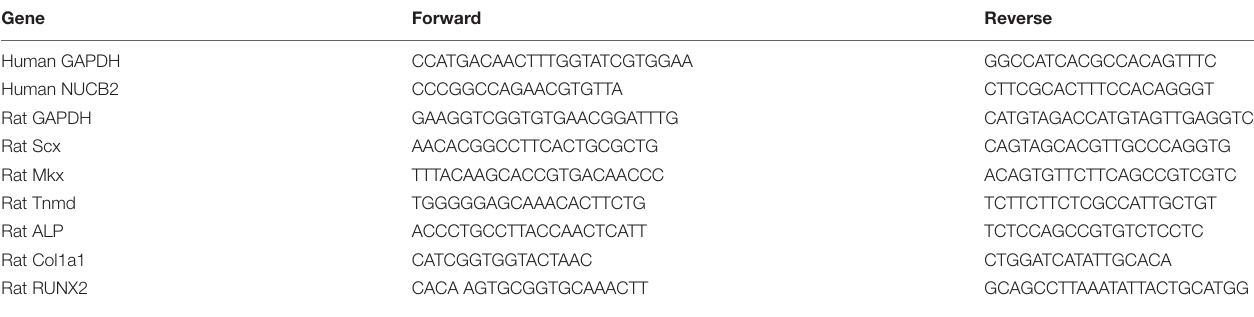
TABLE 1 | Primer sequences used in this study. Gene